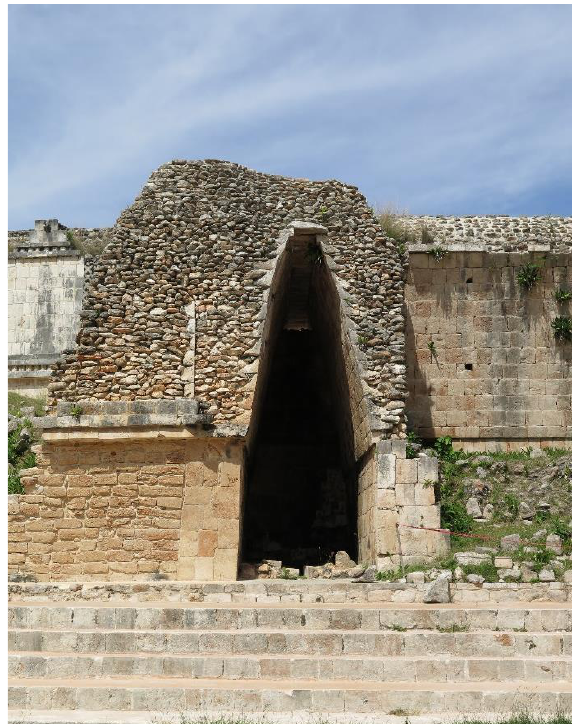
Figure 1. Vault with highly specialized vault stones in the Building 22 of the Puuc site of Uxmal (Yucatan,